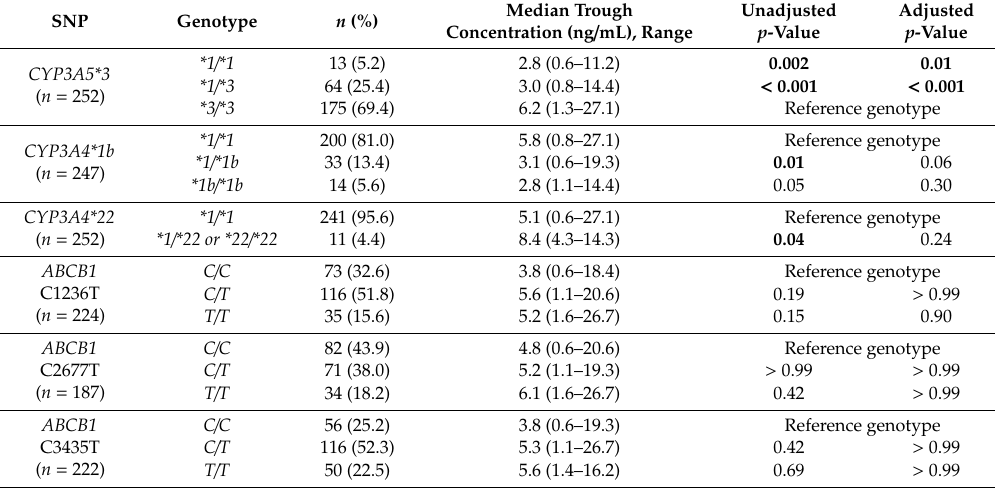
Table 2. Median steady-state tacrolimus trough concentrations for CYP3A4 / 5 and ABCB1 SNPs. Median steady-state tacrolimus concentration levels (ng / mL) were obtained for all patients on the day of the allogeneic HSCT (Day 0). Associations between the tacrolimus concentration and CYP3A4 / 5 genotypes were evaluated. p < 0.05 was considered significant, and reported p values were adjusted for multiple comparisons using the Bonferroni method. Significant associations are bolded below. Abbreviations: HSCT, hematopoietic stem cell transplant; SNP, single nucleotide